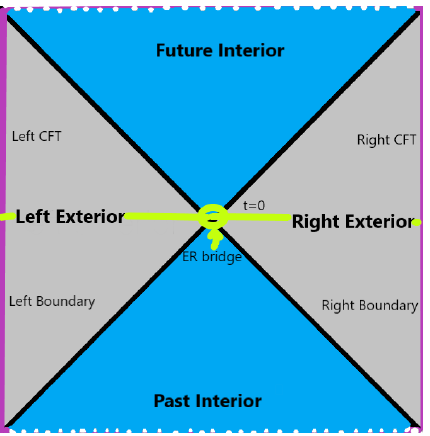
Figure 1. Penrose diagram of the AdS-Schwarzschild black